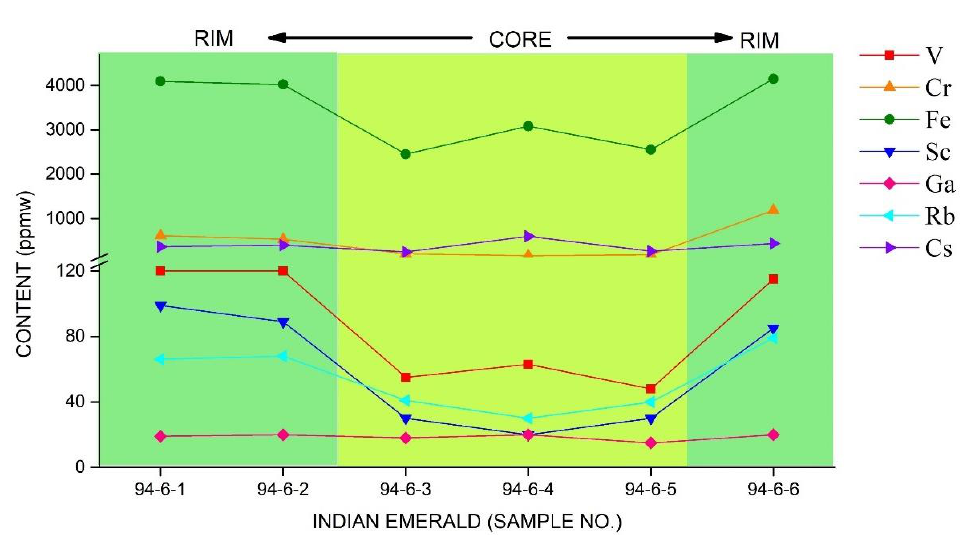
Figure 17. Representative photomicrograph of color zoned emerald crystal 94-6 with a greenish-white core and a medium-green rim. The red circles indicate the positions of analysis points corresponding to analyses 94-6-1 to 94-6-6. LA-ICP-MS data for selected trace element analysis from 94-6-1 to 94-6-6. Plots of V, Cr, Fe, Sc, Ga, Rb, and Cs are used to highlight compositional changes, with uneven ordinate scales for clearer display.